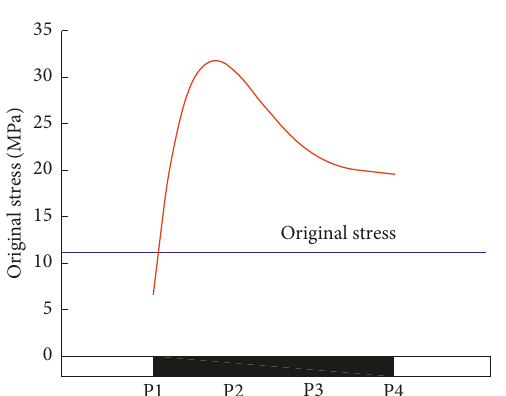
Figure 13: Stress distribution of the pillar in the model.